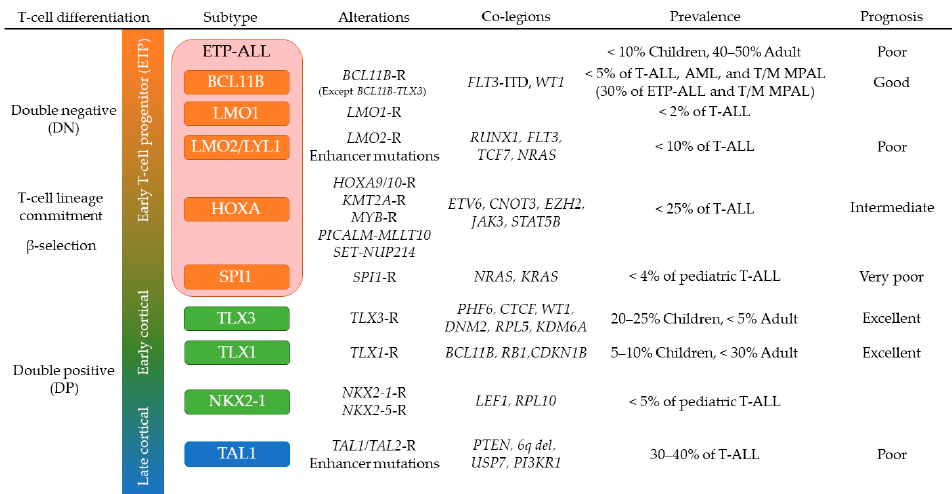
Figure 2. T-cell differentiation and T-ALL subtyping. This schema describes differentiation stages of each T-ALL subtype according to the specific genetic alterations leading to aberrant expression of rearranged or mutated genes. Prevalence and prognosis of each subtype are shown. Subtypes are colored according to corresponding normal T-cell differentiation stage: early T-cell precursor (ETP, red and orange), early stages of cortical thymocytes maturation (green), and late stages of cortical thymocytes maturation (blue). Abbreviations: T-ALL: T-cell acute lymphoblastic leukemia; T/M MPAL: T/myeloid mixed phenotype acute leukemia; -R: rearranged.